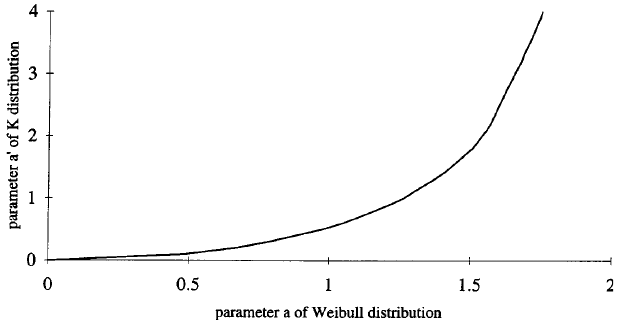
Fig. 12. Plot of parameter a 0 of K distribution versus parameter a of Weibull distribution